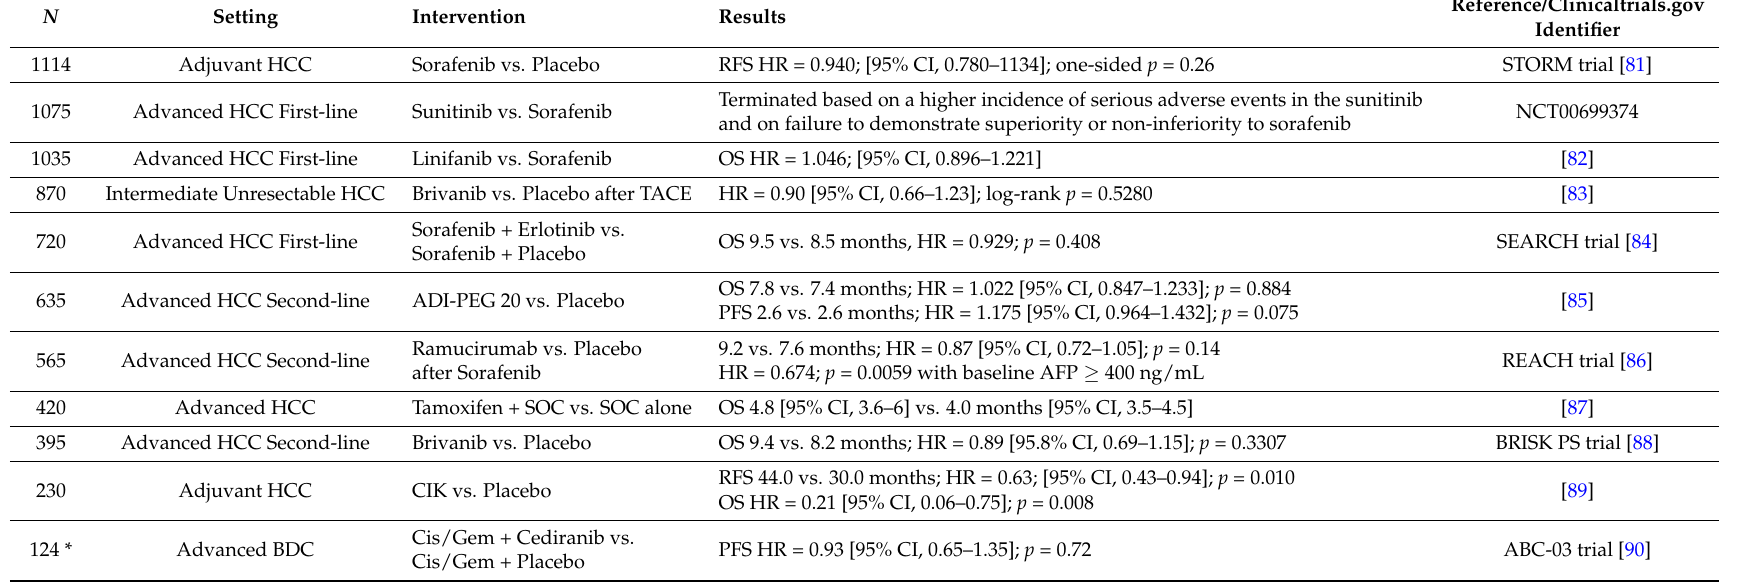
Table 3. Completed Phase III RCTs on targeted drugs for hepatocellular and bile duct